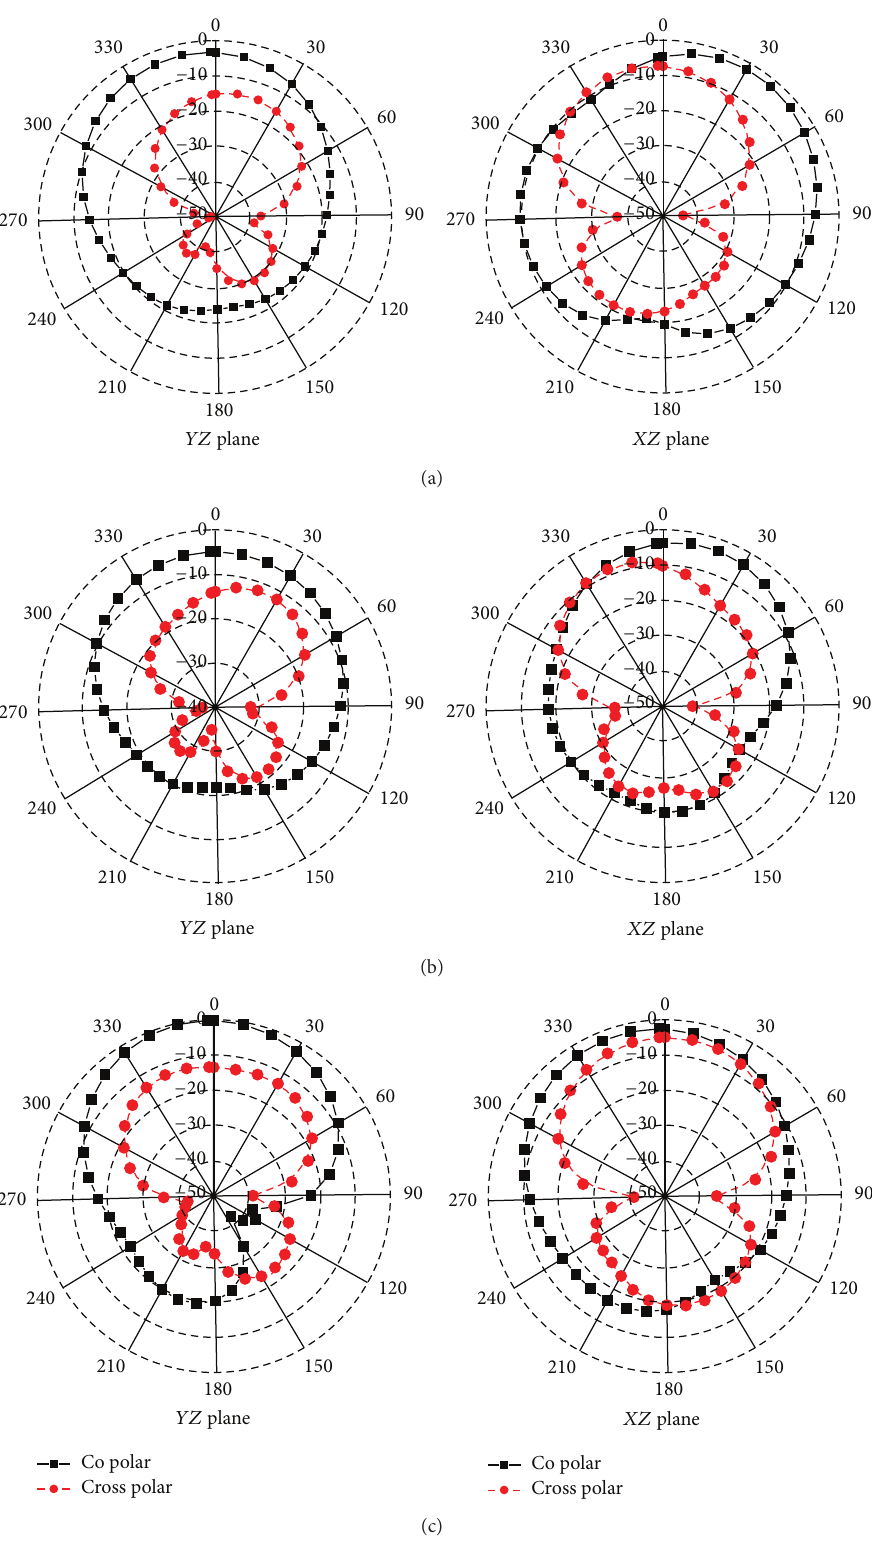
Figure 14: Radiation pattern of the proposed antenna at (a) 3.67 GHz, (b) 5.22 GHz, and (c) 5.8